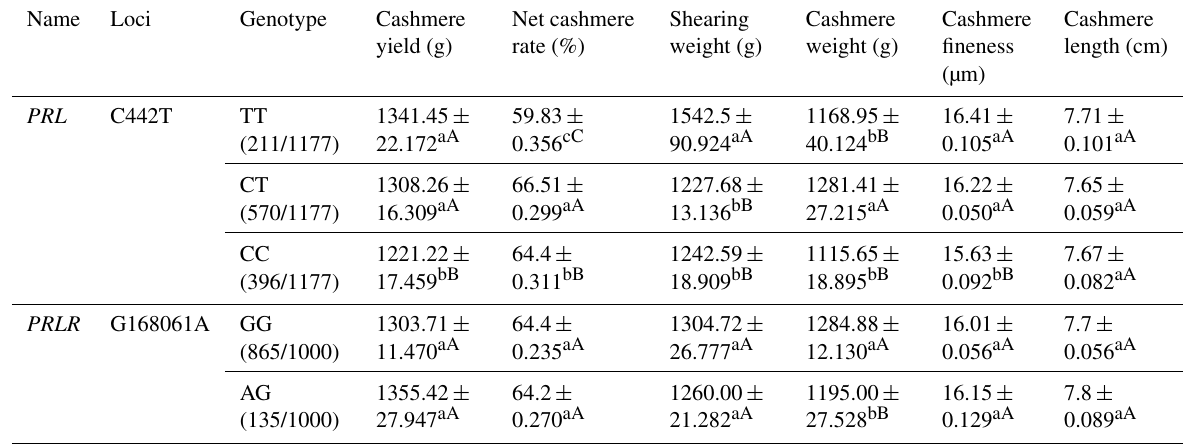
Table A6. Association analysis between PRL and PRLR gene mutation sites and body cashmere performance. Name